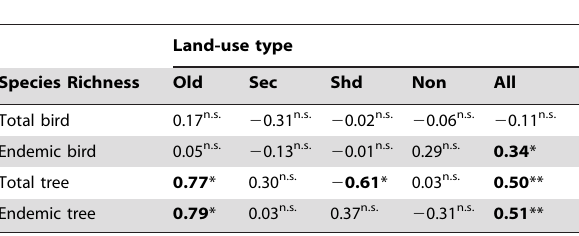
Table 2. Correlation between AGC and observed species richness at the transect